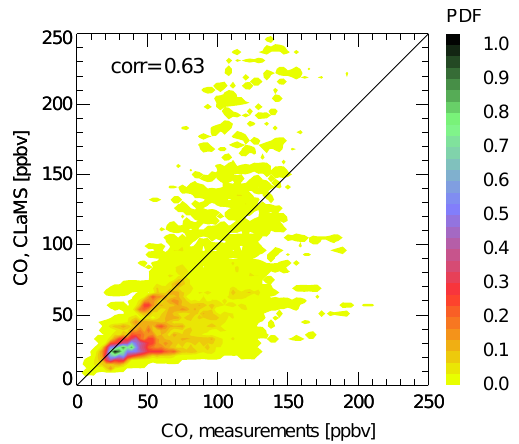
Figure 6. Probability density function for a scatter plot of a clima- tology of aircraft based CO measurements against CLaMS model simulations. The climatology of CO measurements is based on the COLD measurements aboard the Geophysica in the campaigns TROCCINOX (February 2005, Konopka et al., 2007), SCOUT- O3 (November 2005, Brunner et al., 2009), and AMMA (Summer 2006, Cairo et al., 2010) as well as on the TRISTAR CO measure- ments in the mid-latitude tropopause region during the SPURT cam- paign from November 2001 to July 2003 (Hoor et al.,